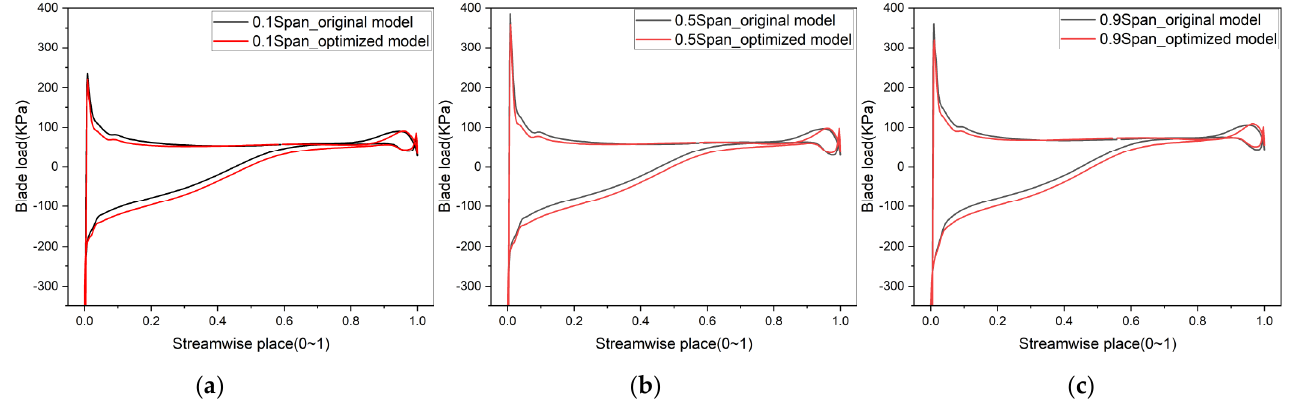
Figure 12. Distribution of blade loads along the span-wise place under the water condition. ( a ) 0.1 span, ( b ) 0.5 span, and ( c ) 0.9 span.